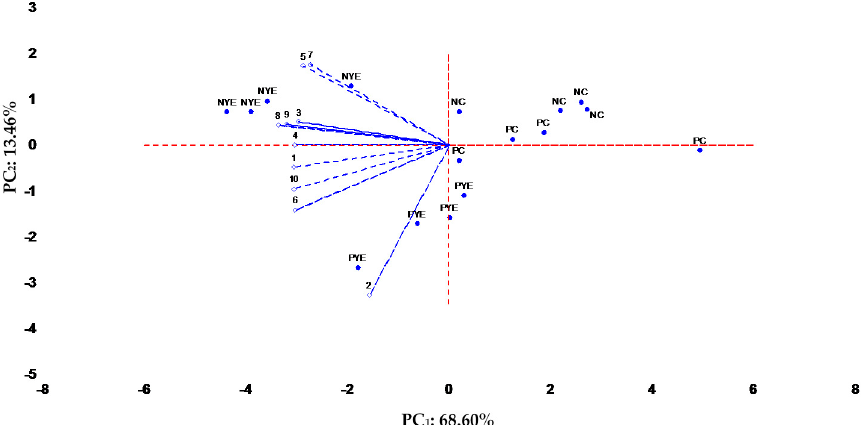
Figure 7. Principal component diagram of carotenoid derivatives in the two grape varieties (N: Negro Amaro; P: Primitivo) as affected by the treatment (C: control; YE: yeast extract). 1, violaxanthin derivative; 2, (9 ′ Z)-neoxanthin derivative; 3, (8 ′ S)-neochrome derivative; 4, 5,6-epoxylutein derivative; 5, luteoxanthin derivative; 6, lutein like structure derivative; 7, Z-lutein like structure derivative; 8, (allE)-lutein derivative; 9, (9Z)-lutein derivative; 10, β -carotene derivative.